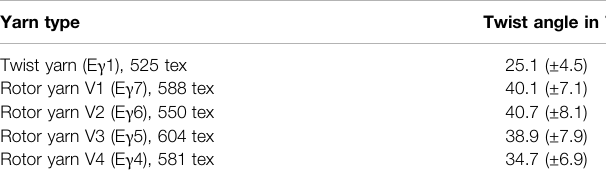
TABLE 2 | Mean twist angles (standard deviation in brackets) of hemp twist yarns and hemp rotor yarns. Yarn